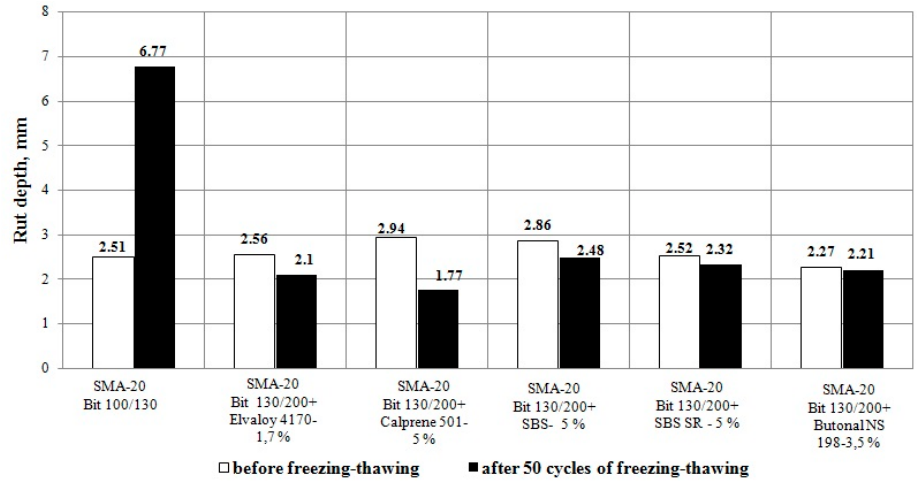
Figure 21. Rut depth on the samples of stone mastic asphalt concretes after 10,000 wheel passes.